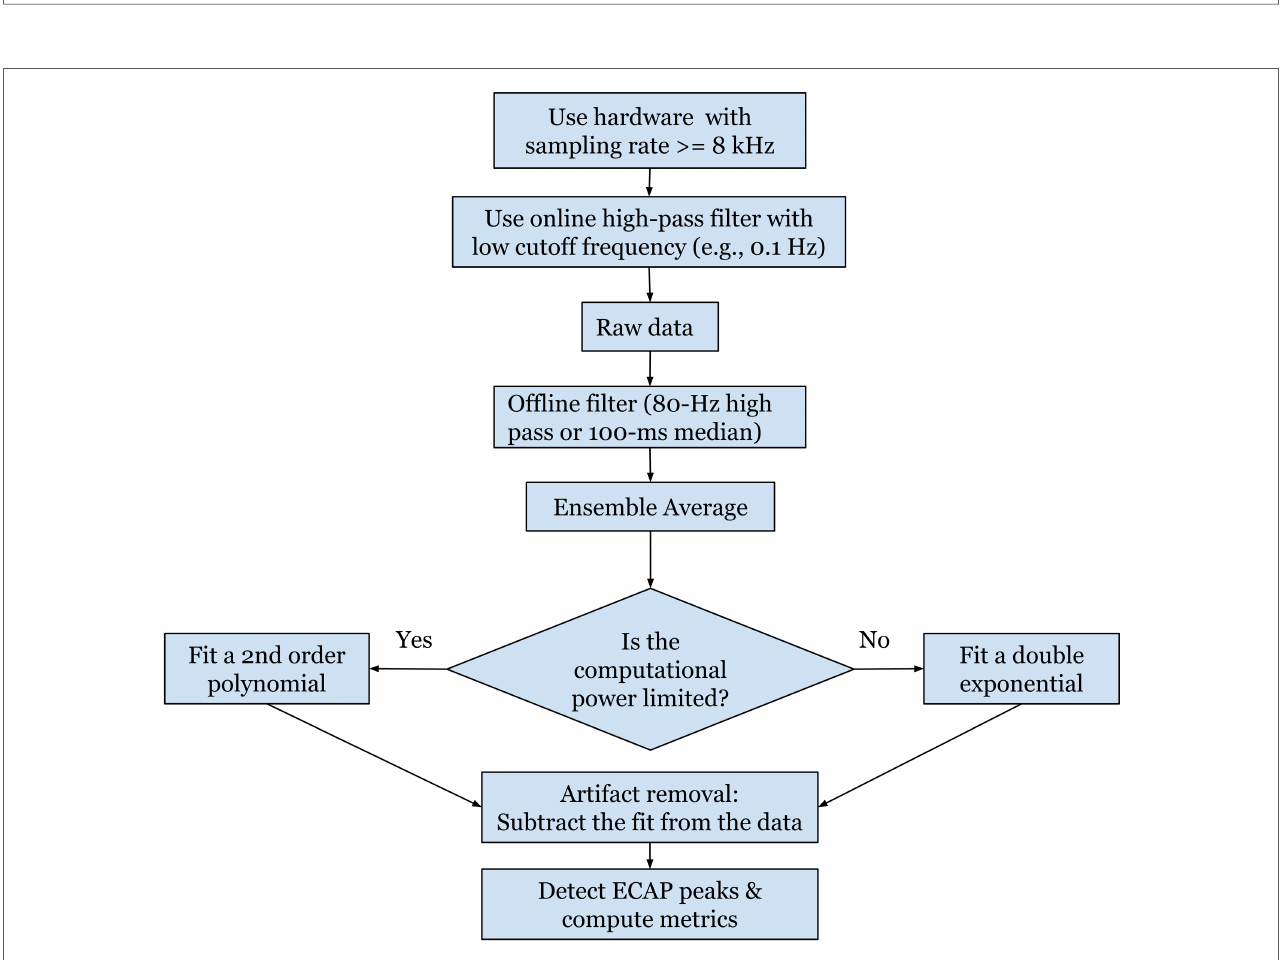
FIGURE 12 A fl owchart summarizing the recommended settings for a robust and standardized protocol for measuring